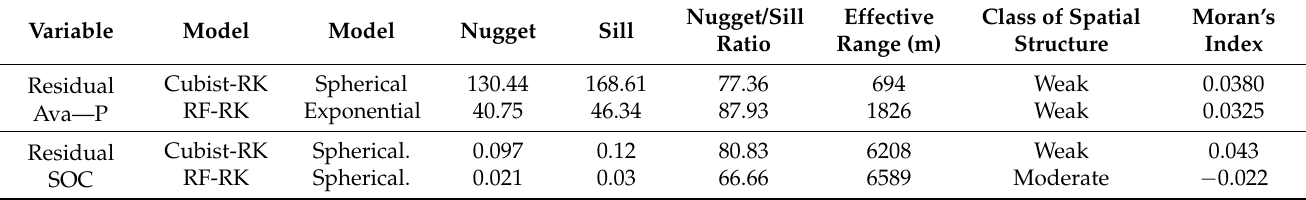
Table 5. Semi variogram model properties of model residuals for phosphorus and organic carbon using random forest and cubist